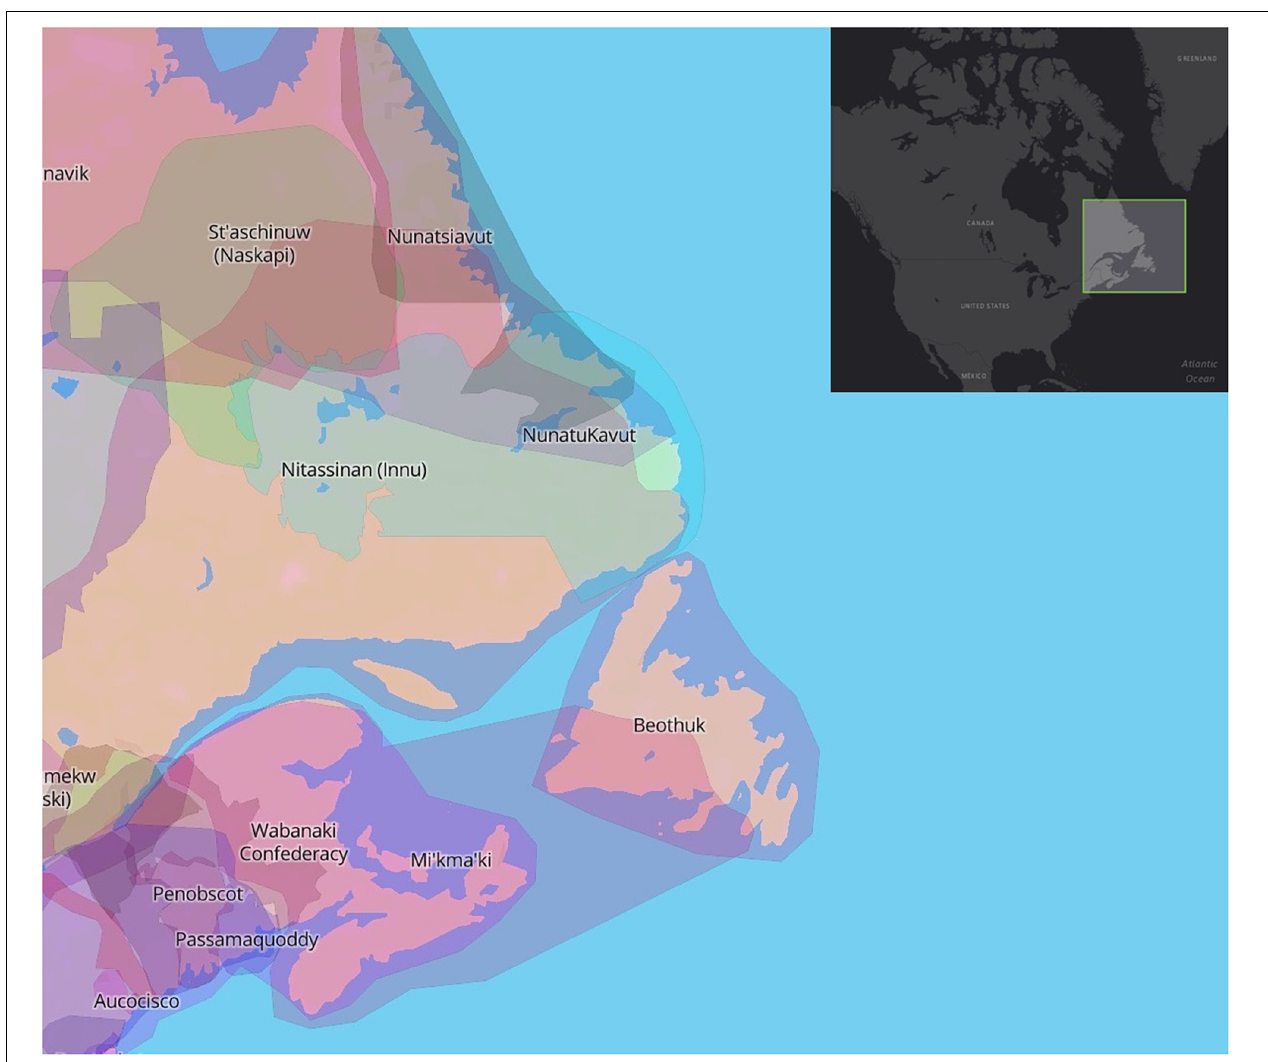
FIGURE 1 | Native Land Digital is an Indigenous-led not-for-profit organization that works to map Indigenous territories according to Indigenous nations themselves. An interactive map allows users to learn about traditional territories, treaties and languages; readers are encouraged to visit native-land.ca for this experience. This screenshot shows the territories on the Atlantic seaboard, with an inset map for global context. CIOOS Atlantic is concerned with the marine areas in this image, excluding the Gulf of St. Lawrence, and with some overlap expected with the future CIOOS Arctic. Screenshot from https://native-land.ca/ on August 10,